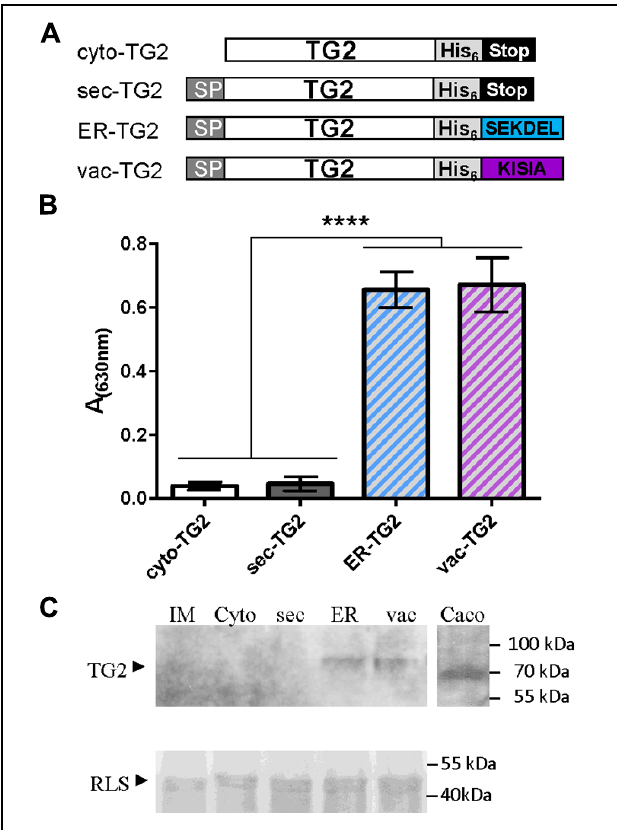
FIGURE 1 | Subcellular targeting strategies tested for stabilize TG2 in leaves. (A) Schematic representation of the TG2 constructs used for Agrobacterium -mediated transient expression in Nicotiana benthamiana leaves. Cyto-TG2 is a cytosolic form of TG2. Sec-TG2, ER-TG2, and Vac-TG2 are introduced in the secretory pathway with murine signal peptide (SP) from gamma 1 antibody chain; SEKDEL, ER retention SP; KISIA is a CT vacuolar targeting signal of the amaranth 11S globulin. Scheme is not drawn to scale. (B) Enzyme-linked Immunosorbent Assay (ELISA) of TG2 fused to the different sorting signals. Microwells were coated with the same amount of total leaves extract overnight at 4 ◦ C. After blocking, anti-TG2 mAb 2G3 was added, followed of incubation with a biotin-conjugated anti-mouse, later with HRP-conjugated streptavidin and developed with TMB peroxidase substrate. Three biological replicates (each replicate containing five leaf disks of the infiltrated tissue from a different plant) were used for ELISA. Error bars represent the standard error of the mean (SEM). ∗∗∗∗ Denotes statistically significant difference by Tukey’s multiple comparisons test ( P < 0.001). (C) Western blot of TG2 fused to the different sorting signals. Expression levels were measured by scanning densitometry of Western Blot developed with 2G3 mAb with a minimum of three independent experiments. The amount of total extract was adjusted using RLS stained with Coomassie Brilliant Blue R-250 as loading